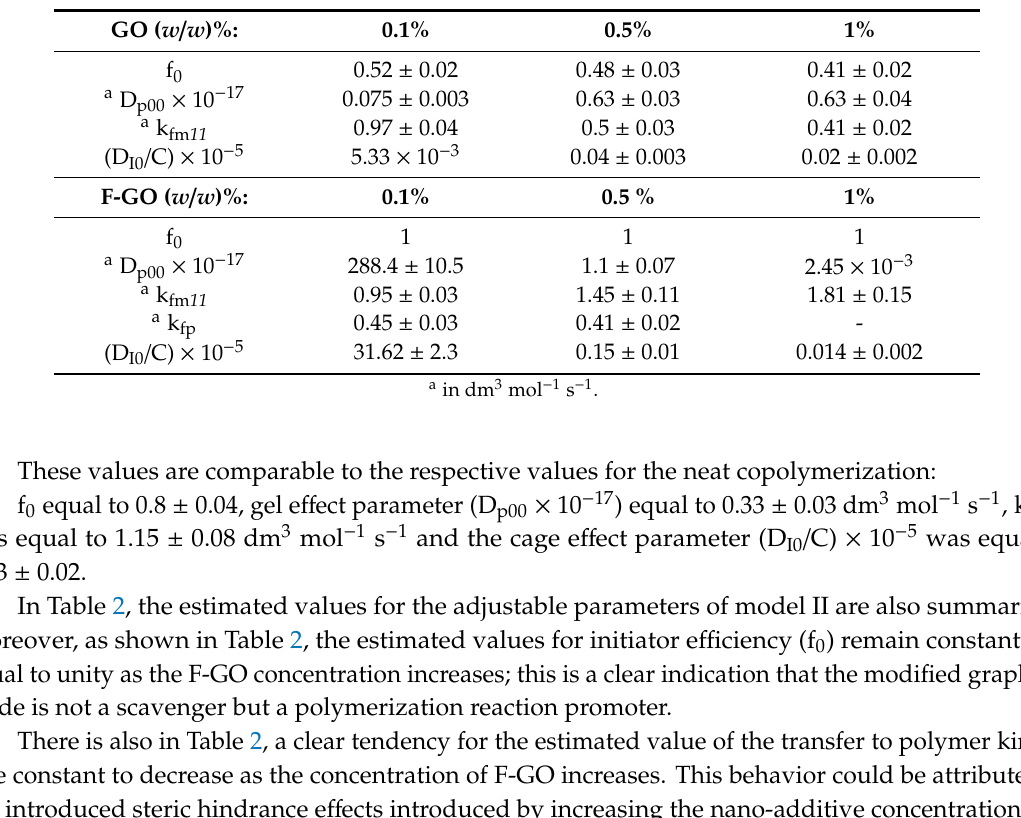
Figure 7. Cumulative conversion vs. polymerization time at various functionalized graphene oxide (F-GO) contents (Model II) for P(S- co -BMA) 20:80. Table 2. Values of Adjustable Parameters used in Simulations for P(S- co -BMA) 20:80